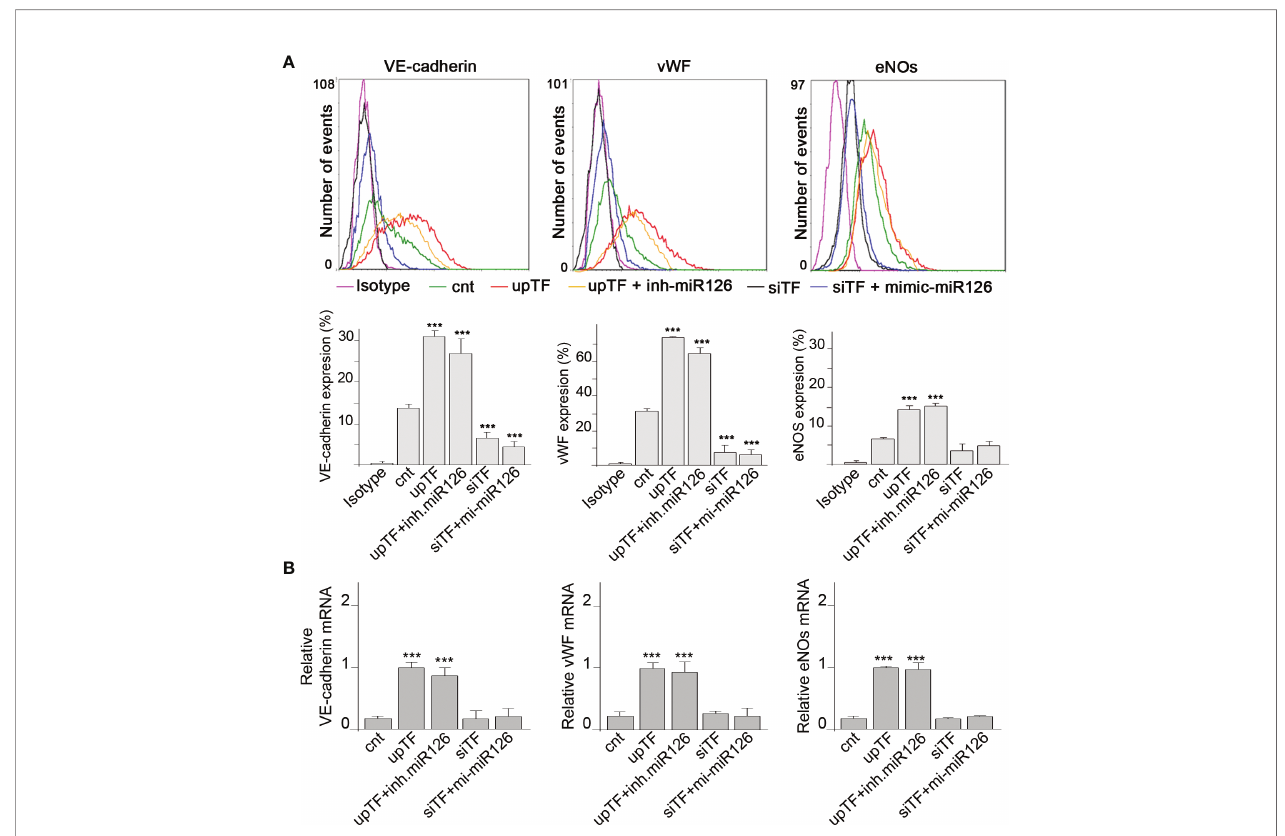
FIGURE 2 | MiR-126 in EMVs does not induce vascular endothelial cell markers in RMCs. (A) Expression protein of VE cadherin, von Willebrand factor (VWF), and eNOS was analyzed by fl uorescence-activated cell sorting (FACS) analysis in RMCs after 8 days of treatment with EMVs obtained from ECs transfected with control (empty vector) (cnt), TF overexpression vector with or without inhibitor miR-126, or TF silencing with or without mimic-miR-126. Unspeci fi c IgG antibody was used as a control. Histograms show analysis from 6 experiments. Values are expressed as mean ± SEM. Statistical analysis was performed by ANOVA followed by Tukey ’ s post-hoc test. *** p < 0.001 vs. RMCs treated with cnt-EMVs. (B) mRNA expression of VE-cadherin, von Willebrand factor (VWF), and eNOS was analyzed by qRT- PCR in RMCs after 8 days of treatment with EMVs obtained from ECs transfected with control (cnt), TF overexpression vector with or without inhibitor miR-126, or TF silencing with or without mimic-miR-126. Values are expressed as mean ± SEM. Statistical analysis was performed by ANOVA followed by Tukey ’ s post-hoc test. *** p < 0.001 vs. RMCs treated with